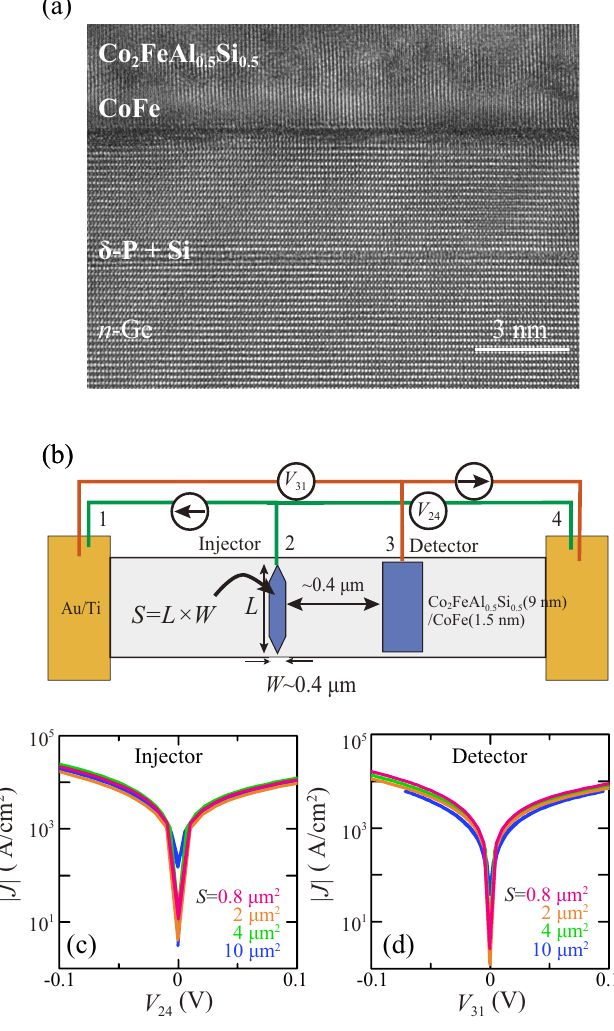
Figure 2. ( a ) Cross-sectional TEM image of the FM/ n -Ge interface of a measured lateral spin valve (LSV) device; ( b ) Schematic illustration of the terminal configuration for | J |– V measurements; | J |– V curves for ( c ) spin injector and ( d ) spin detector with various contact sizes at 30